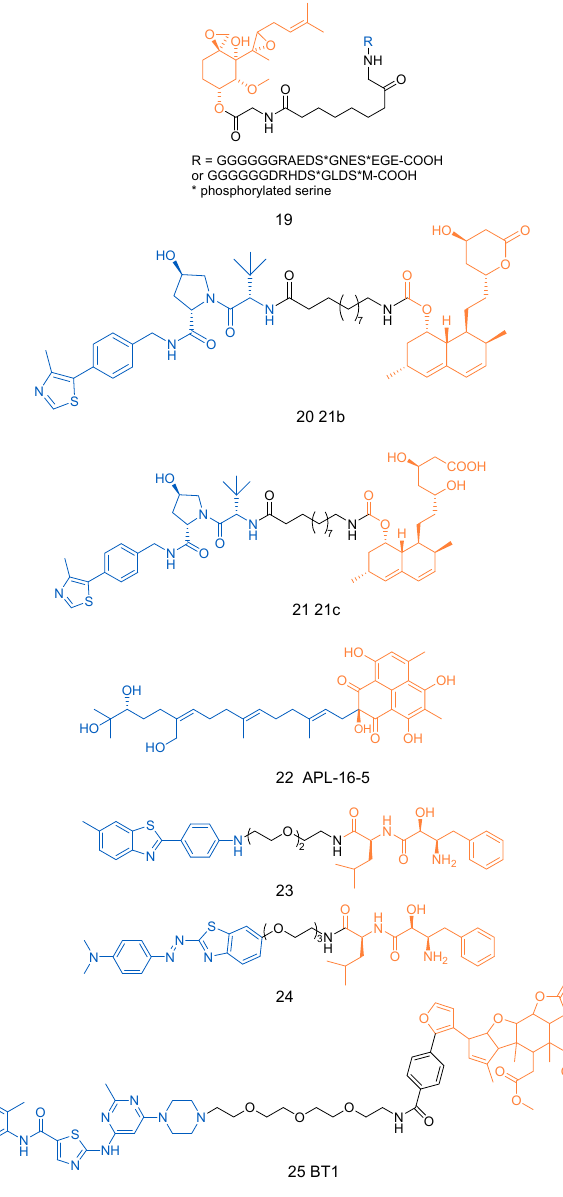
Figure 2. The structures of PROTACs presented in this review. ( A ) The structures of PROTACs 1–5f. ( B ) The structures of PROTACs 6–11f. ( C ) The structures of PROTACs 12-18f. ( D ) The structures of PROTACs 19–25f.